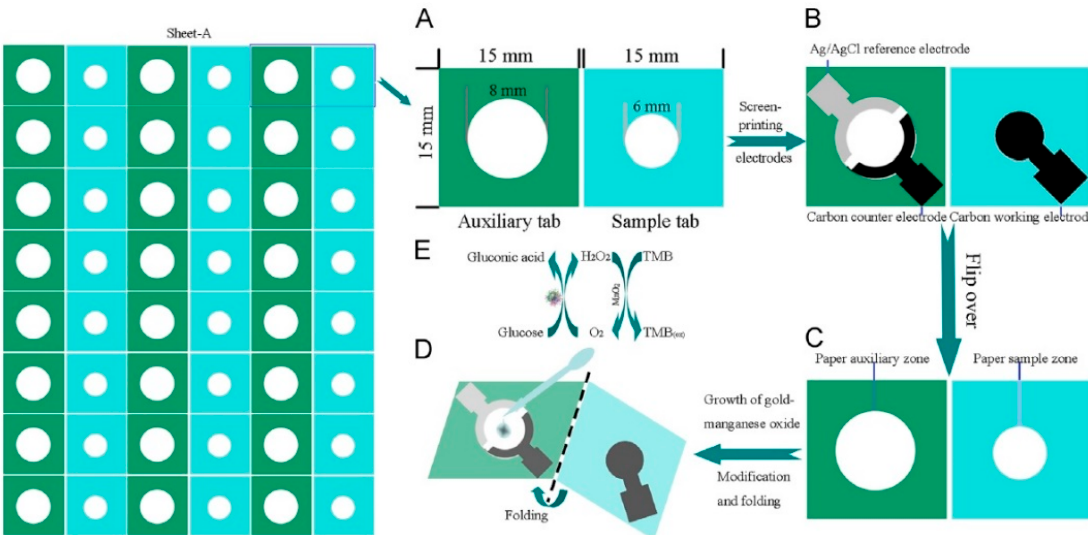
Figure 6. Schematic representation of the 3D origami device and assay procedure. Wax pattern of paper sheet (sheet-A) and ( A ) Single 3D origami device without the screen-printed electrodes. ( B , C ) Then electrodes were screen-printed on sheet-A and cut into individual 3D origami device. ( D ) After modification, the device was used to detect PSA exploiting an enzymatic reaction ( E ). Reproduced with permission from [76].